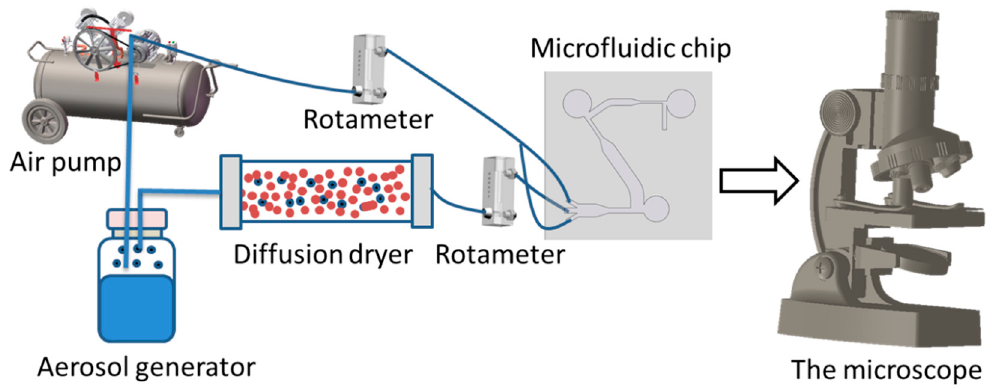
Figure 6. Schematic diagram of the microfluidic chip experimental setup.